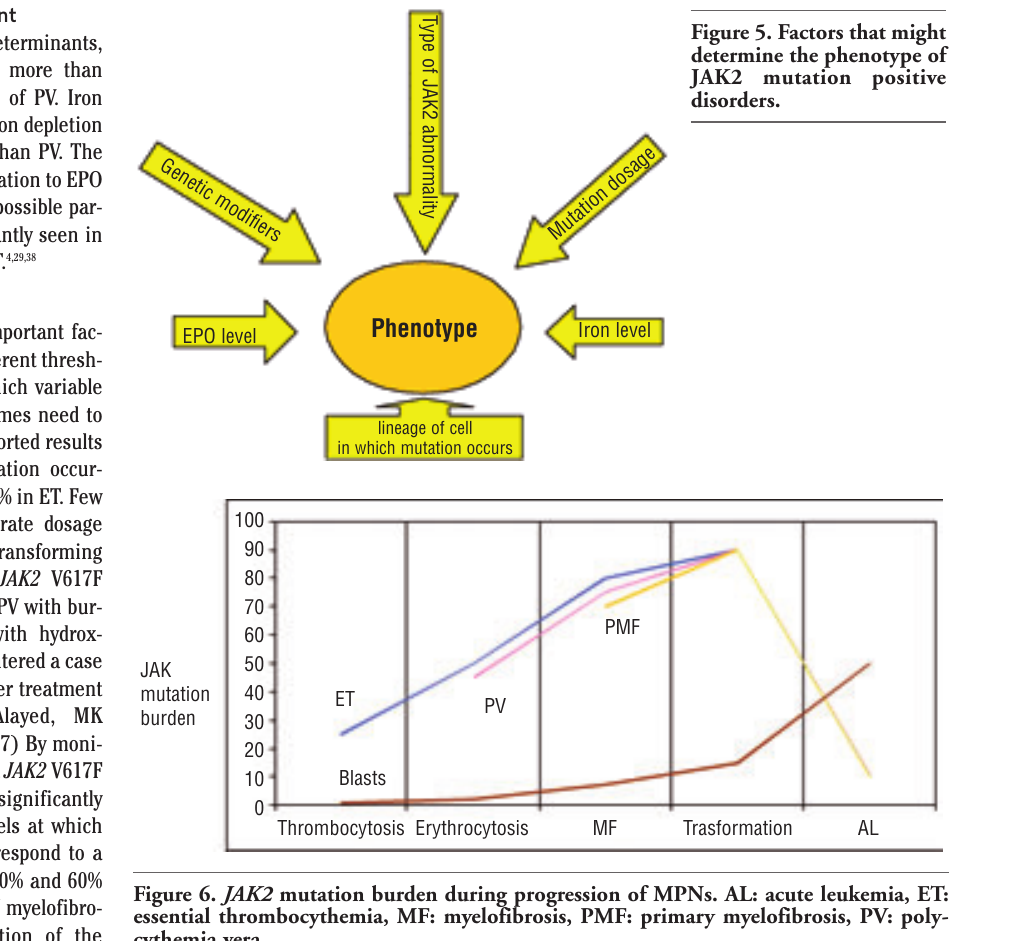
Figure 5. Factors that might determine the phenotype of JAK2 mutation positive disorders.